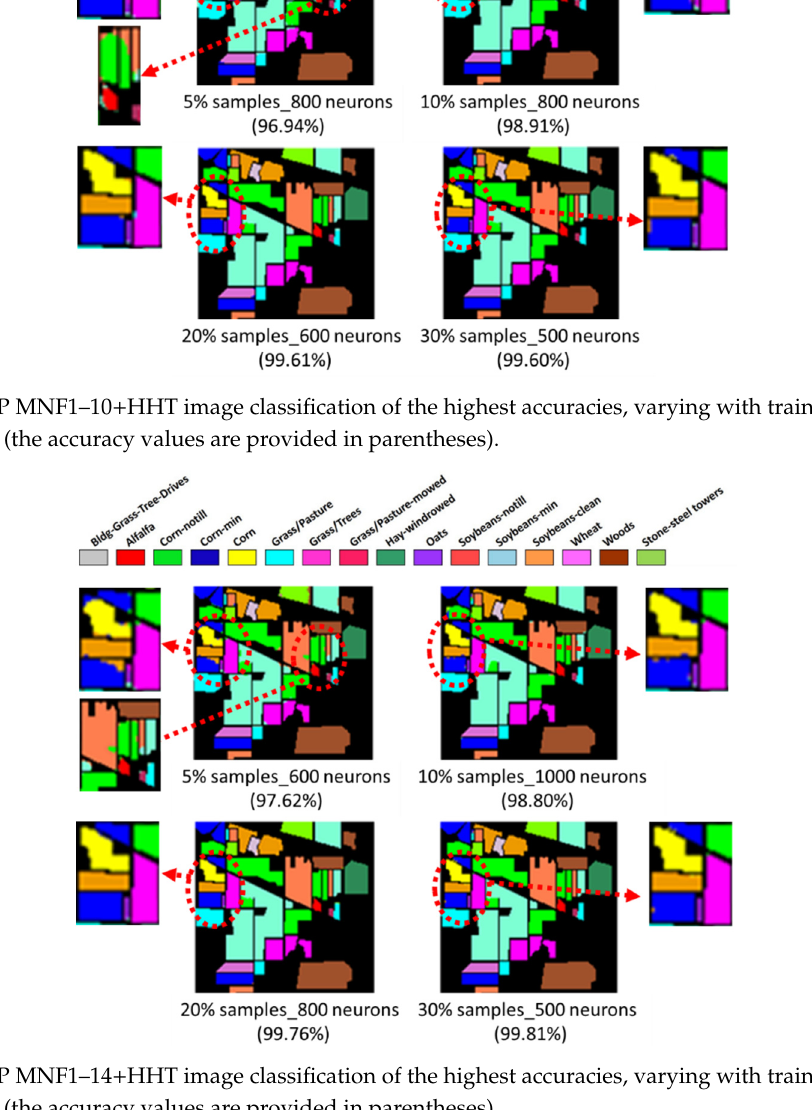
Figure 14. MNF1 to MNF14 images of the PaviaU dataset. 4. Conclusion To enhance HSI classification, this study proposes a process integrating MNF and HHT to reduce image dimensions and decompose images. Specifically, MNF and HHT function as feature extractor and image decomposer, respectively, to minimize the influences of noises and dimensionality. This study tested two variables, the number of neurons and training sample proportion, to evaluate the variation of ANN classification accuracy. For both the IP and PaviaU hyperspectral datasets, the statistically significant classification accuracy improvement indicated that the proposed MNF+HHT process had excellent and stable performance. The major contributions and findings can be summarized as follows. 1.